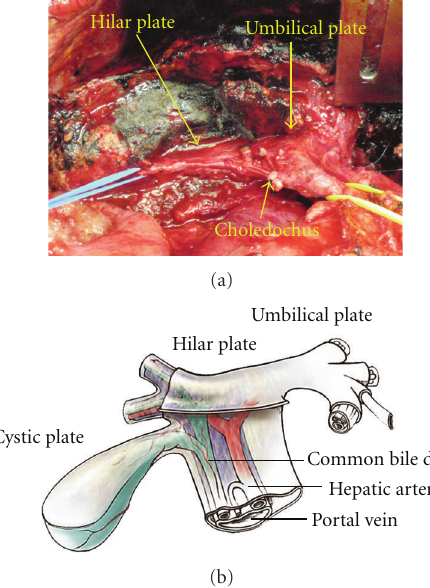
Figure 7: The view of the hilar plate after complete eradication of the infiltrating tumor. The right portal pedicle is tapped by blue tape. The oozing blood from the liver surface is controlled by ABC. Dissection of mucinous tumor from the hilar plate after taping the right portal pedicle branches. This excision only involves surgical removal of Glisson’s capsule bearing tumor and approximately 1- 2cm in depth of hepatic